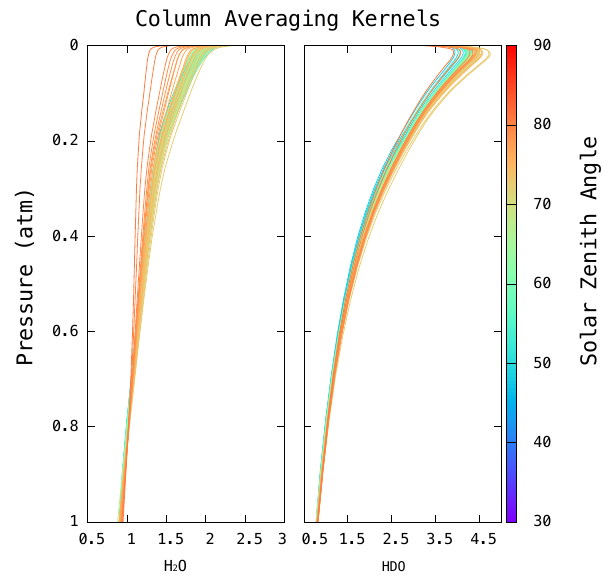
Figure 11. H 2 O and HDO column averaging kernels for different solar zenith angles.